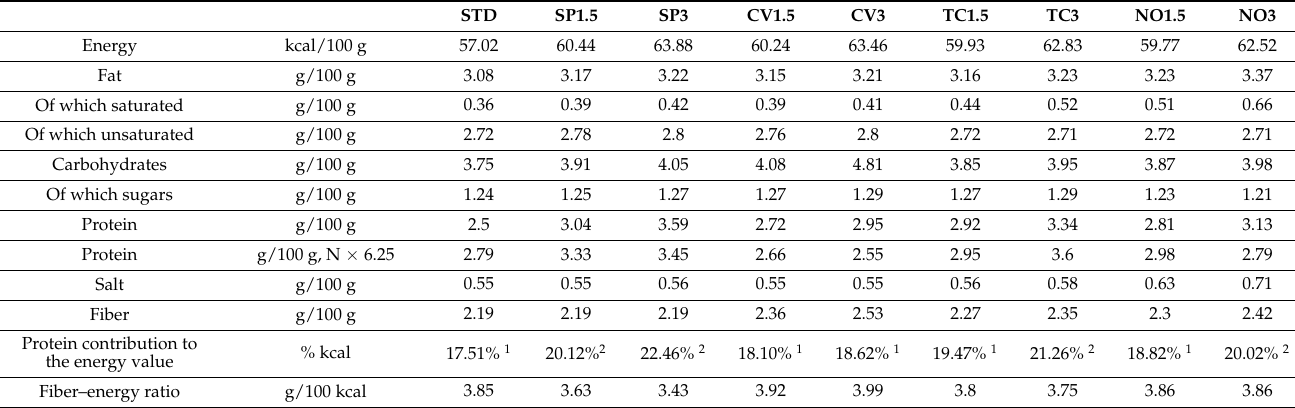
Table 4. Nutritional labeling of vegetable creams formulated with microalgae at different levels of